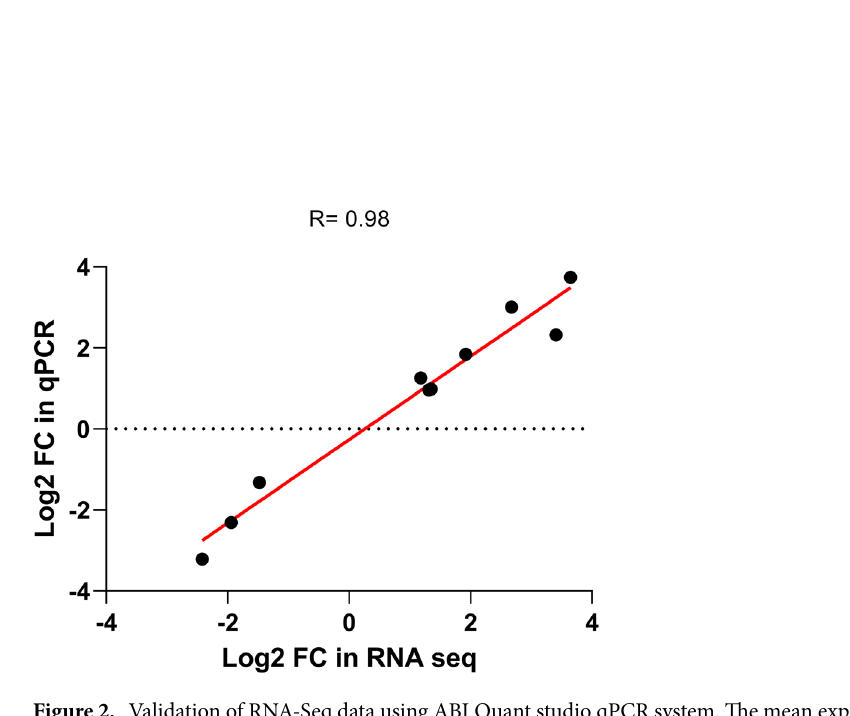
Figure 1. The volcano plot of differentially expressed genes between challenged and control birds. Red dots indicate significantly up-regulated (p < 0.05, log2 fold change ≥ 1) and down-regulated genes (p < 0.05, log 2 fold change ≤ − 1). Black dots represent genes that were not differentially expressed.